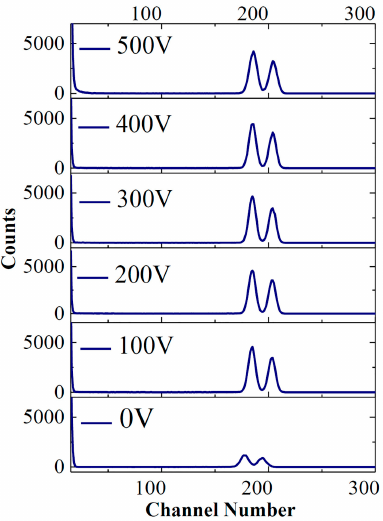
Figure 4. Response of the 4H-SiC detector to alpha particles emitted by 243 Am and 244 Cm at reverse bias voltages of 0, 100 V, 200 V, 300 V, 400 V, and 500 V.